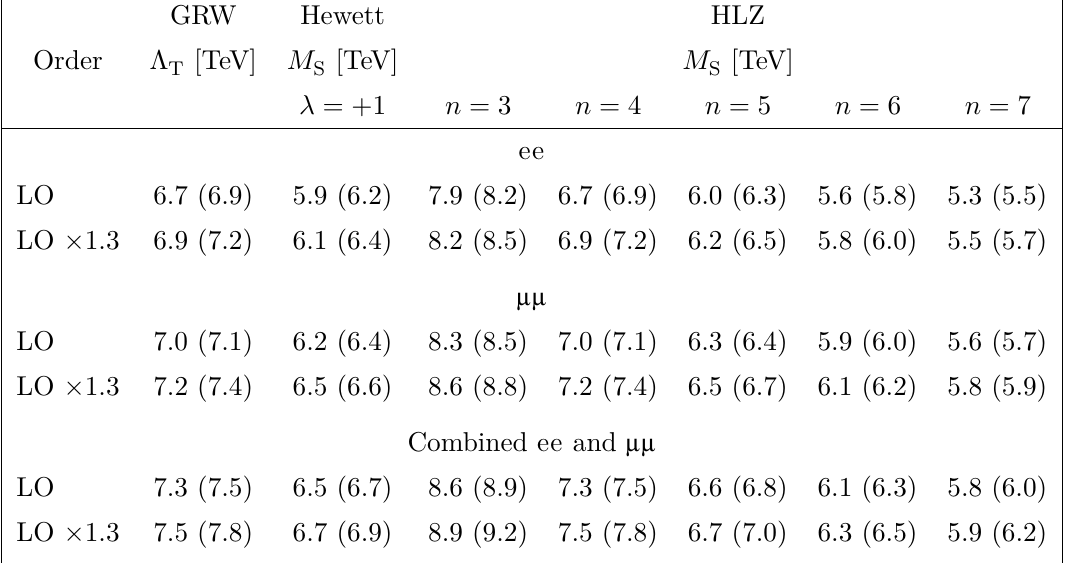
Table 7 . Exclusion limits at 95% CL for the electron and muon channels, and their combination, for various parameter conventions of the ADD model. Signal model cross sections are calculated up to LO and the NNLO correction factor of 1.3 is applied. For each of the model parameters, the observed limit is shown first, followed by the expected limit in